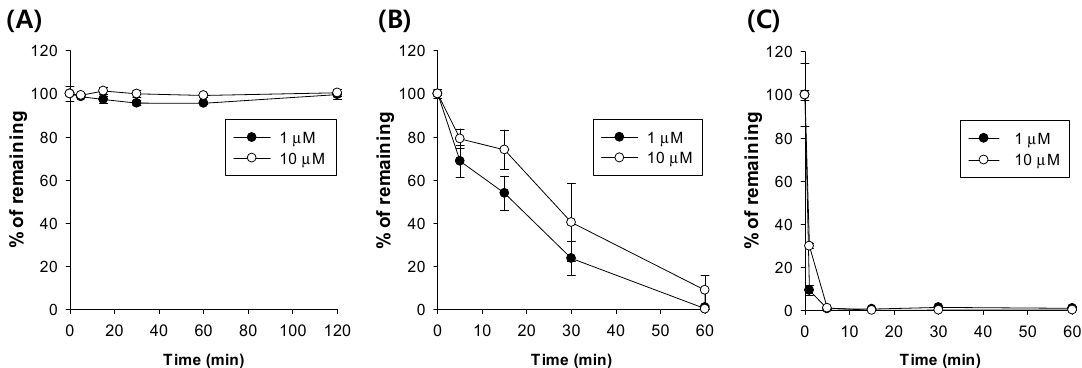
Figure 4. Metabolic stability of ATEC in ( A ) phosphate-buffered saline (pH 7.4), ( B ) rat plasma, and ( C ) rat liver microsomes.